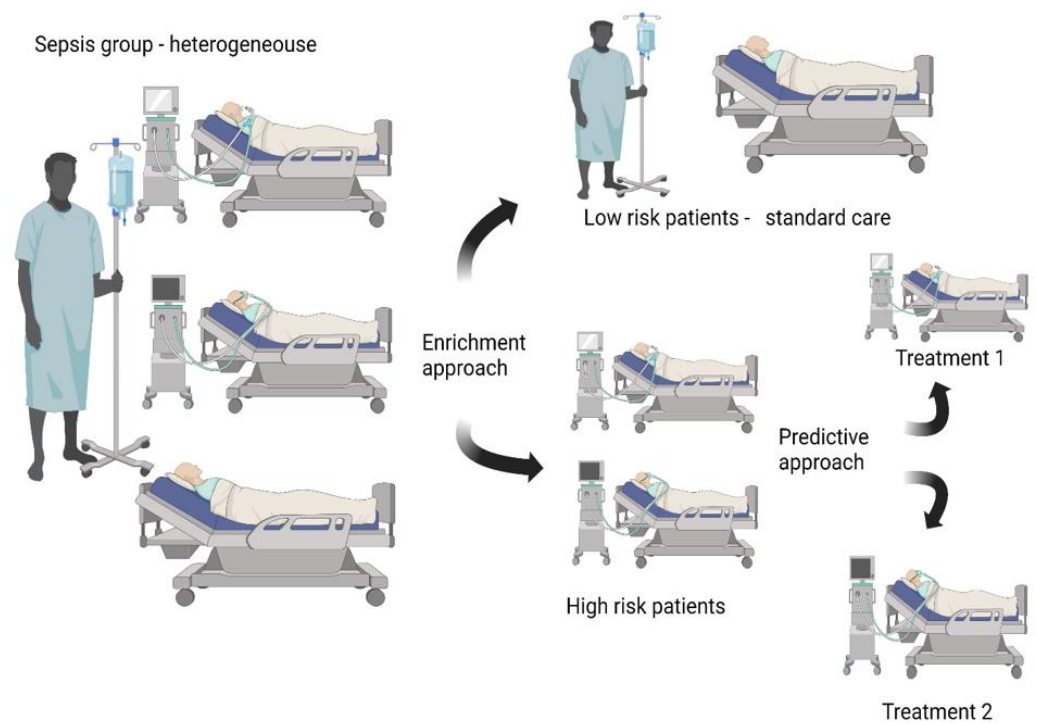
Figure 4. Enrichment approach method for personalized medicine in septic patients.